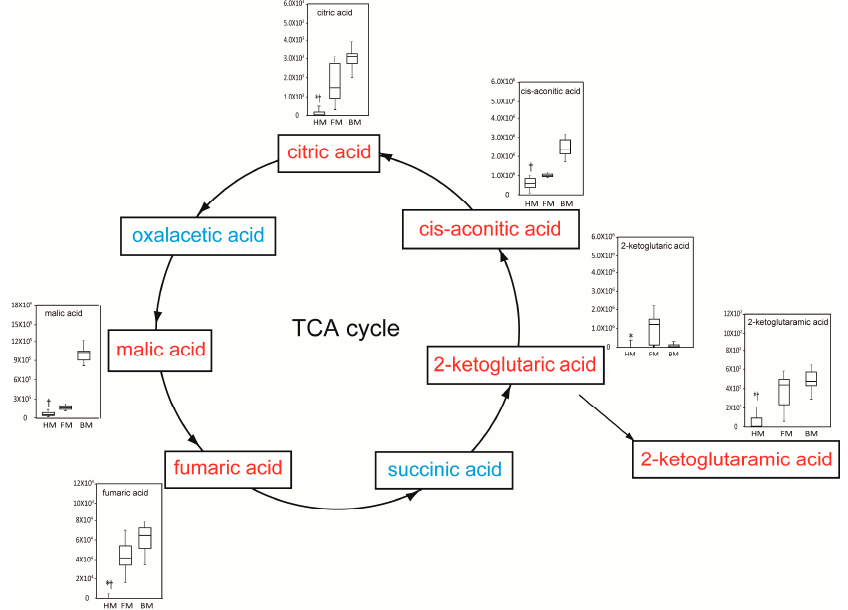
Figure 5. Bar plot of tricarboxylic acid (TCA) intermediates that significantly differed among HM, FM and BM. Blue labeling represents no significant difference among milk types. Red labeling represents a significant difference among milk types. The Y -axis represents the normalized peak area. Boxes contain the 25%–75% measurements for each group, and whiskers cover the 5%–95% measurements. The horizontal lines within the box represent the median values. * p < 0.05 vs. FM; † p < 0.05 vs. BM. Kruskal–Wallis H test followed by Bonferroni-corrected post-hoc test. HM, human breast milk; FM, formula milk; BM, bovine milk.